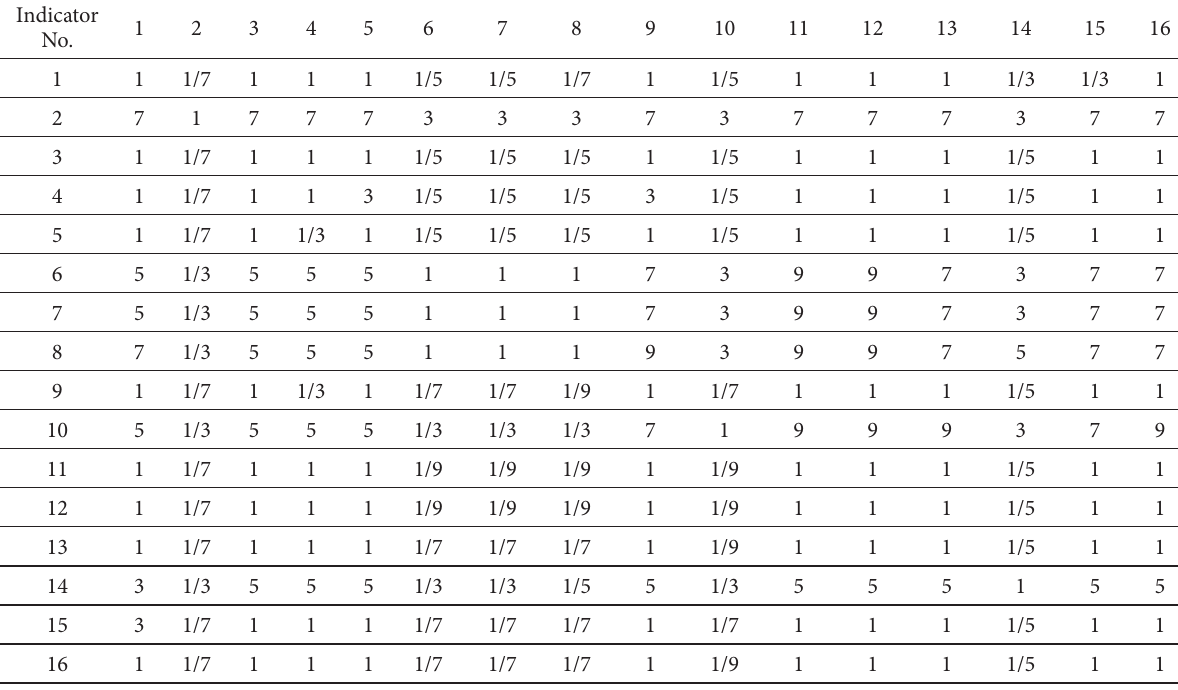
Table 1. An example of the pairwise comparison of indicators related to train elements and the technical state of railway track as per one respondent questionnaire Indicator